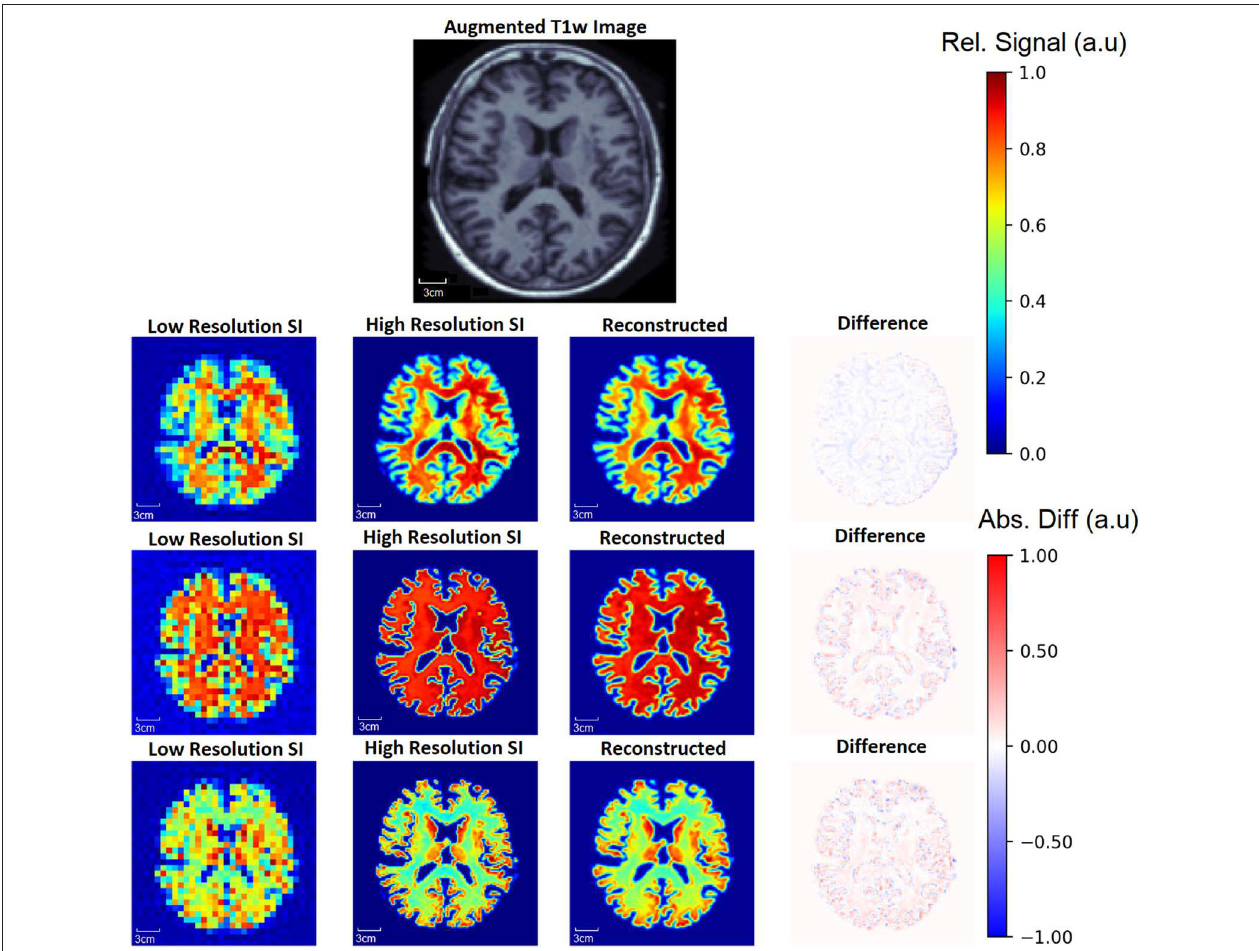
FIGURE 6 | From one augmented T1w image, the generator is capable of producing multiple ground truth high resolution (High Resolution SI) images and low resolution (Low Resolution SI) images, a small sample of which are shown. In this example, the top row shows images where metabolite signal is higher in WM. In the middle row, the metabolite signal is equal in WM and GM, whereas the metabolite signal is higher in the GM in the bottom row. Since a single input T1w image can produce many augmented T1w images, the generator allows for an exponentially large number of unique training data. The reconstruction for each aT 1 w image and LRSI is performed with the 32x32 D-UNet to yield the reconstructed HRSI images (Reconstructed). The difference maps are produced by subtracting the reconstructed and ground truth images.